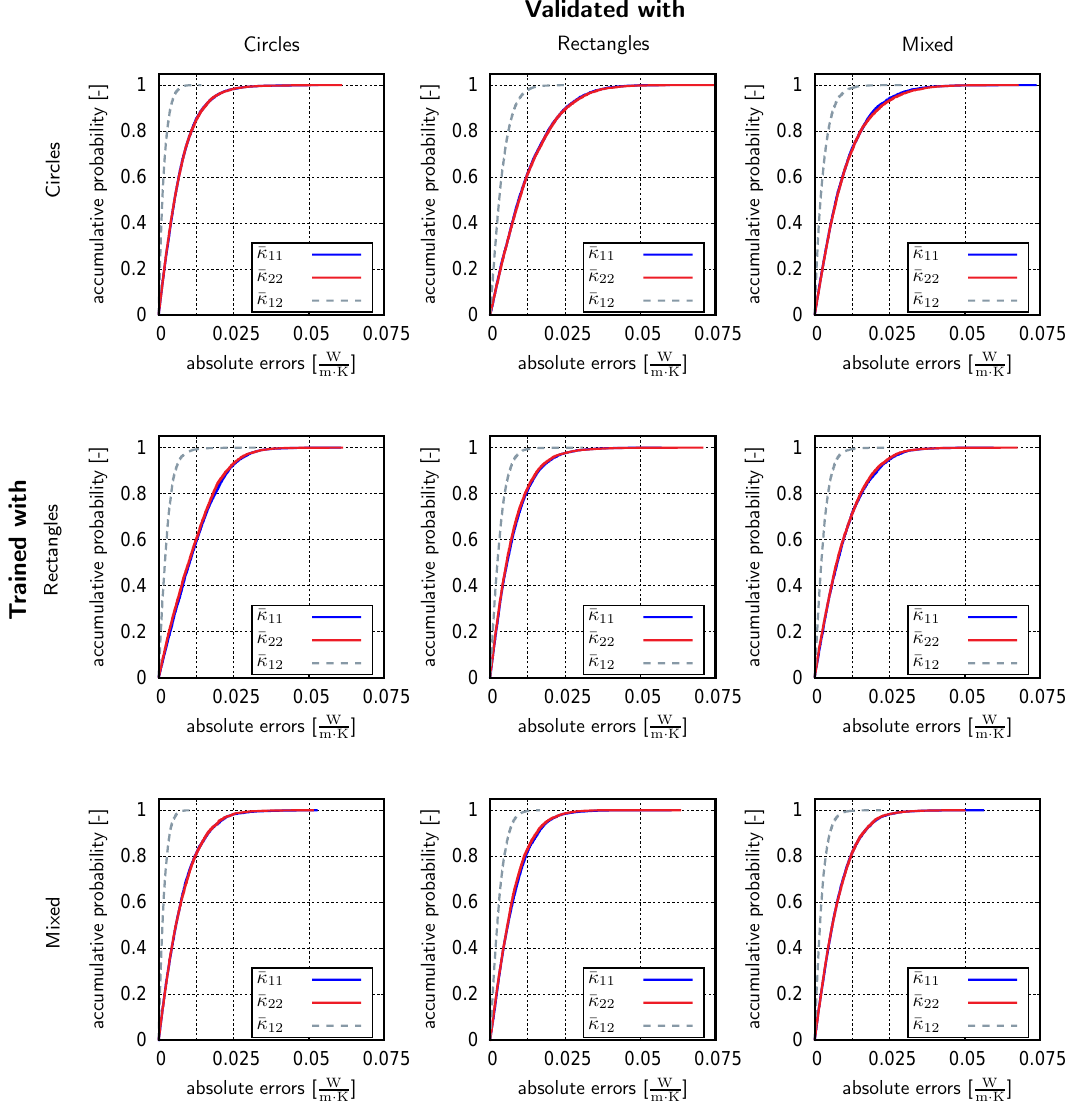
Figure 11. Results for the best of all tested ANN for the test sets. The graphs represent a probability distribution of the absolute error in each component of ¯ κ .